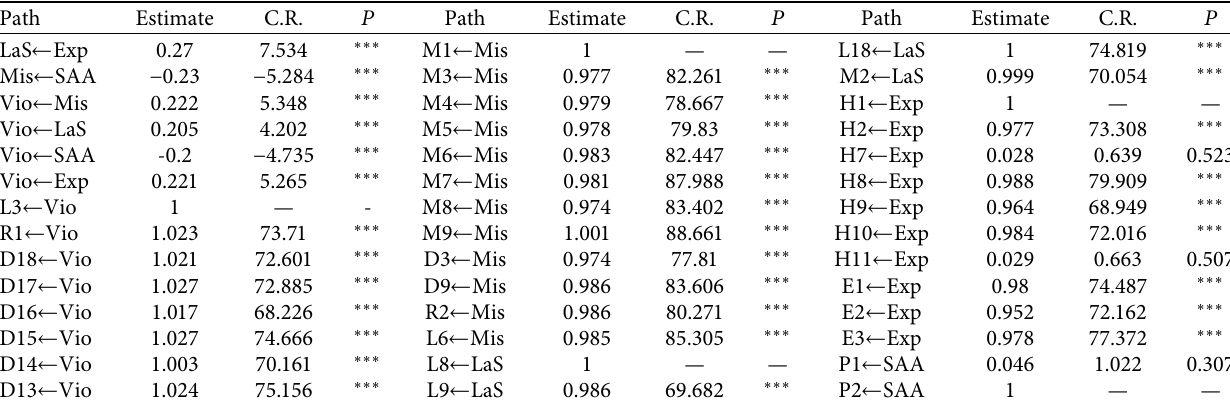
Table 8: Path coefficients of the hypothetical structural